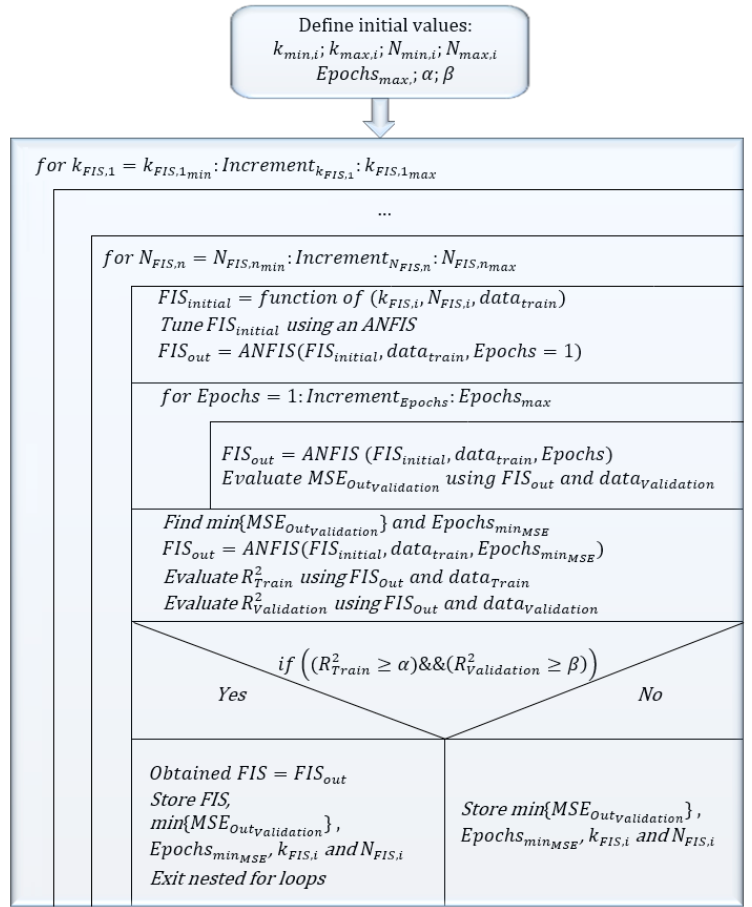
Figure 3. Flowchart of the proposed method. Table 4. Estimated coefficients for 𝑓 (cid:2869) using the train data and the RSM model.